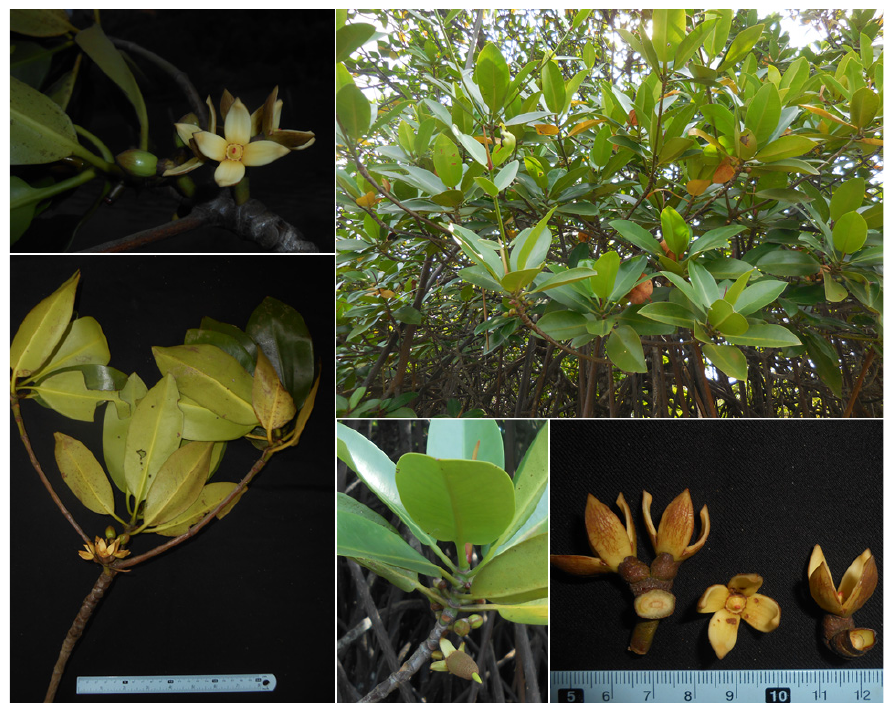
Figure 1. Rhizophora apiculata collected from the Bu Lu mangrove forest, Phu Loc district, Thua Thien Hue province, Vietnam.